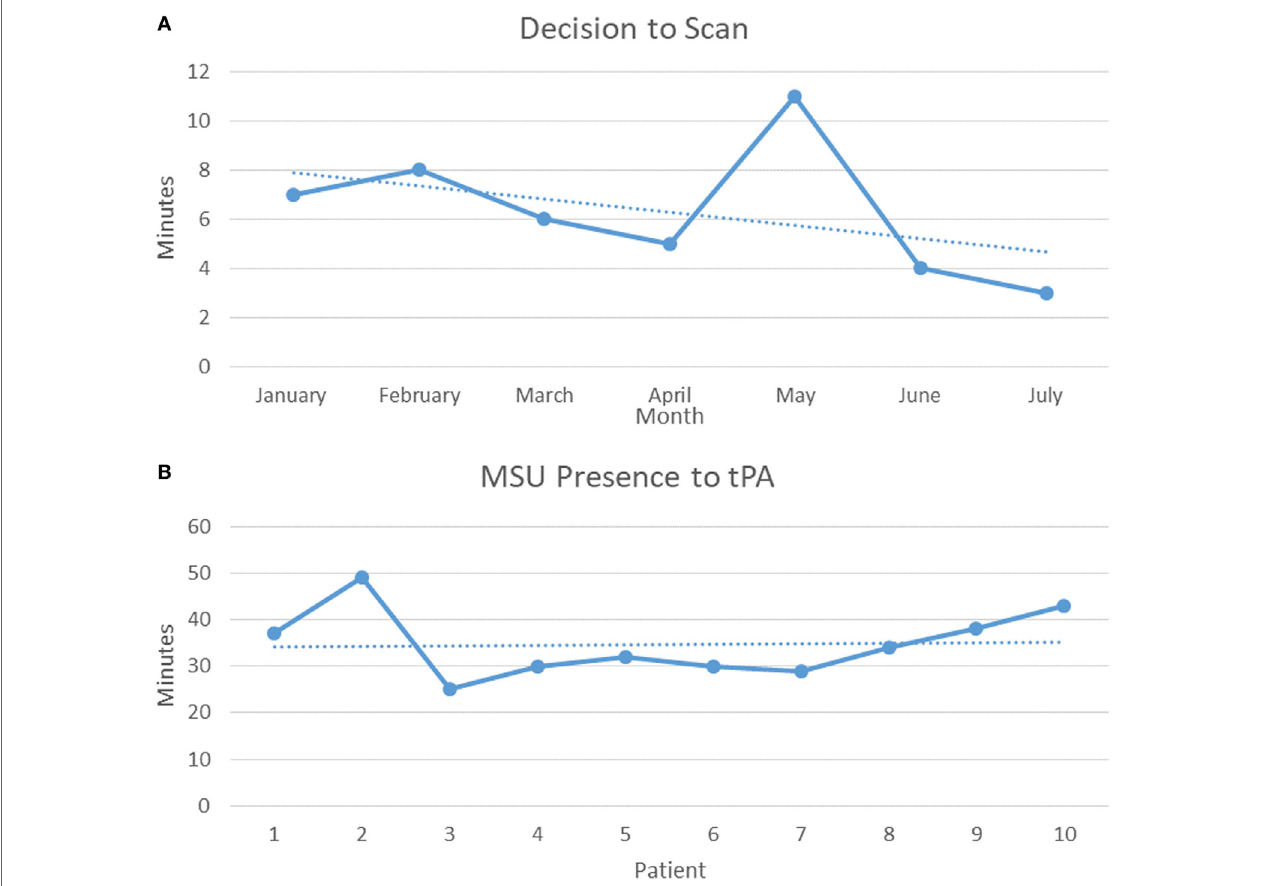
FigUre 2 | (a) First 6 months trend of average decision to scan time. (B) First 10 Mobile Stroke Unit (MSU) tPA patients from on-scene arrival to tPA